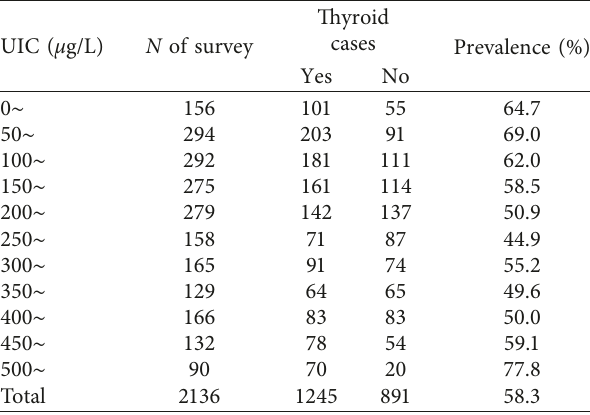
Figure 3: Prevalence of thyroid diseases in different UIC levels. Table 8: The influence of different urine iodine concentration on the prevalence of thyroid diseases.